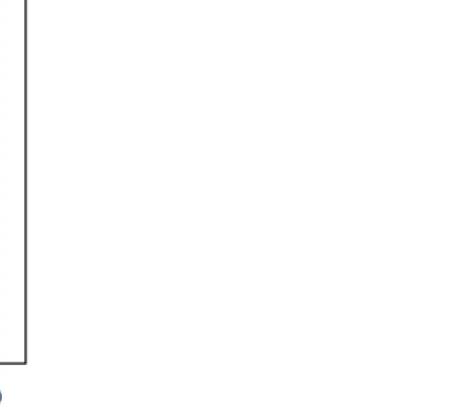
Figure 4. Scavenging capacity comparison of Trp-Met-x-PMO (x = 5, 10, 15, 20, 40, 60, 100) on ABTS free